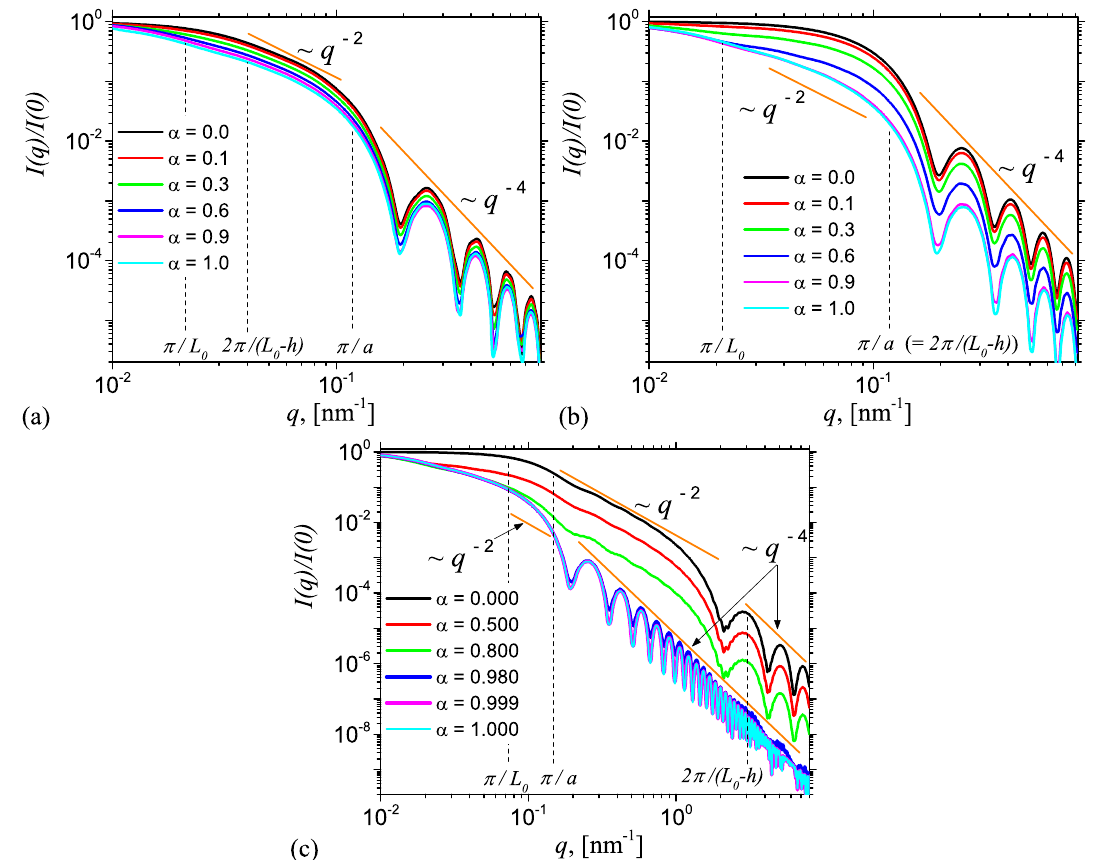
Figure 6. (Color online) SAS intensity from radially symmetric JC with diameter 2 a = 40 nm and height 2 L 0 = 280 nm calculated using Equation (19), when Region 2 is found at various heights h above a middle-plane parallel to the bases: ( a ) h = 0 nm; ( b ) h = 100 nm; and ( c ) h = 137 nm. α is the contrast parameter given by Equation